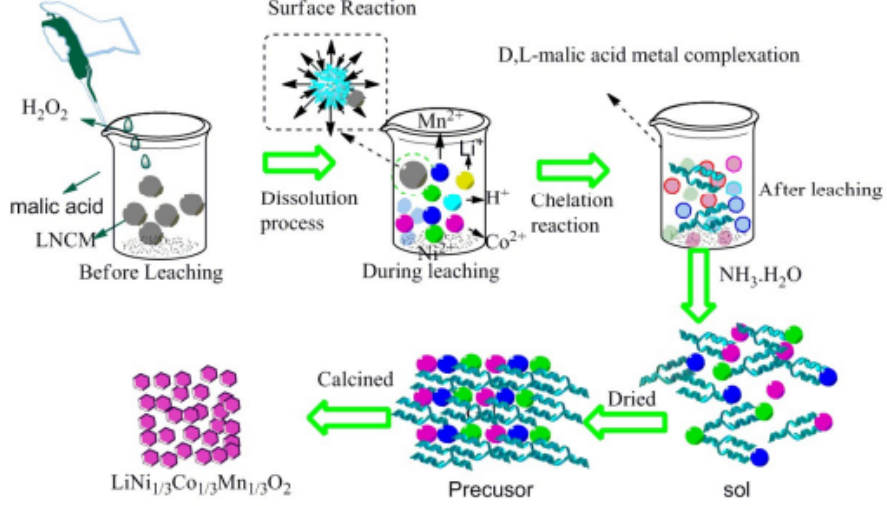
Figure 6. The illustration of the D, L-malic acid leaching process of the waste NCM and the coordination of the main metal ions with D, L-malic acid. Used with permission of Royal Society of Chemistry, from Ref. [60]; permission conveyed through Copyright Clearance Center, Inc.